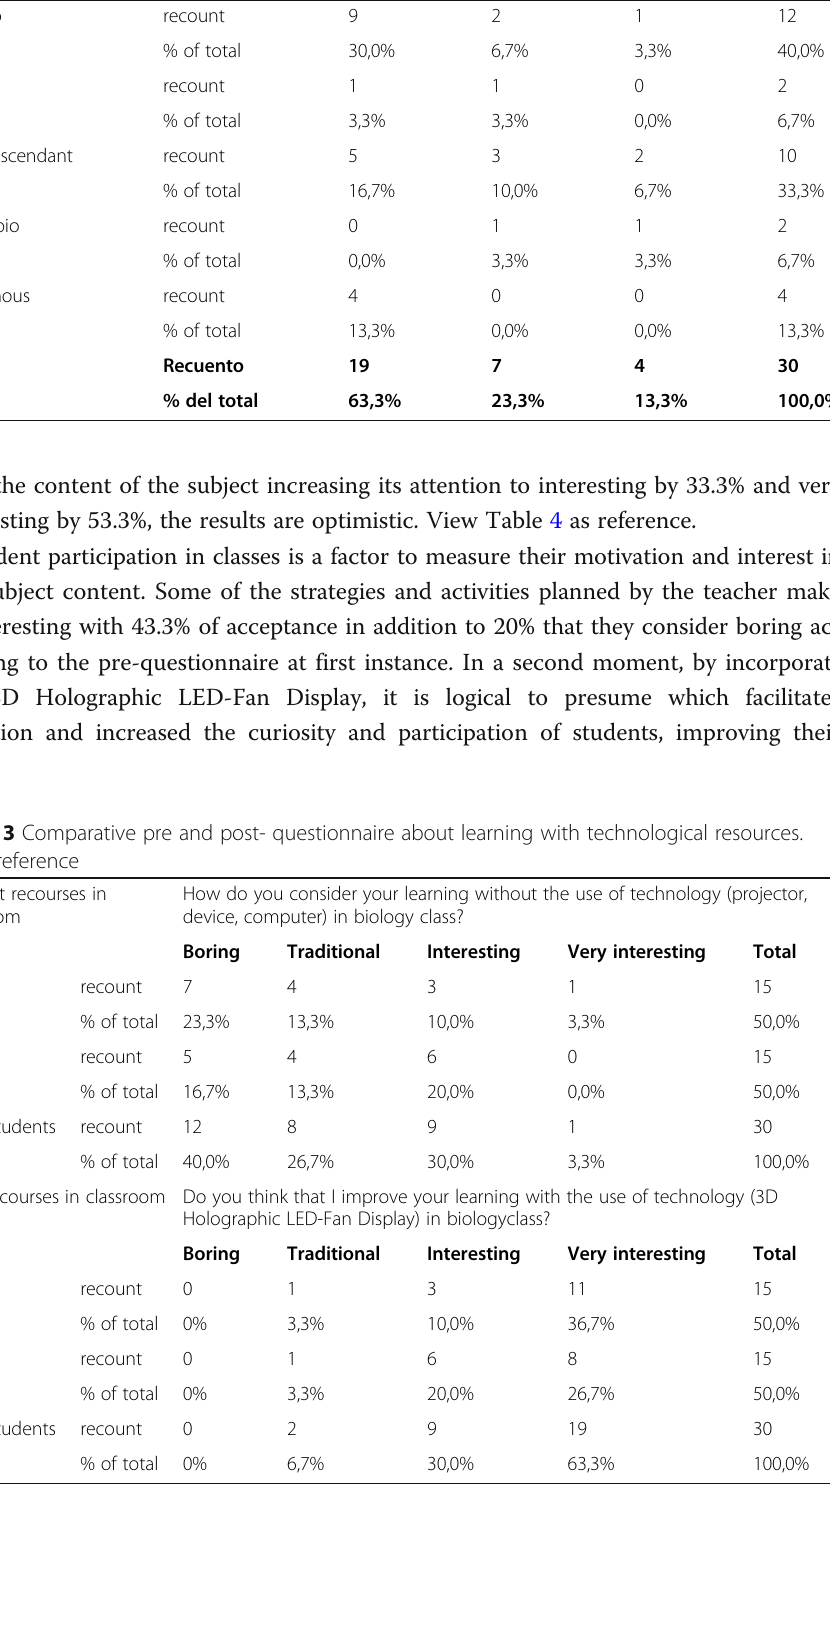
Table 2 Participants students, cross reference Gender: Female 15; Male: 15, Total 30 Ethnicity